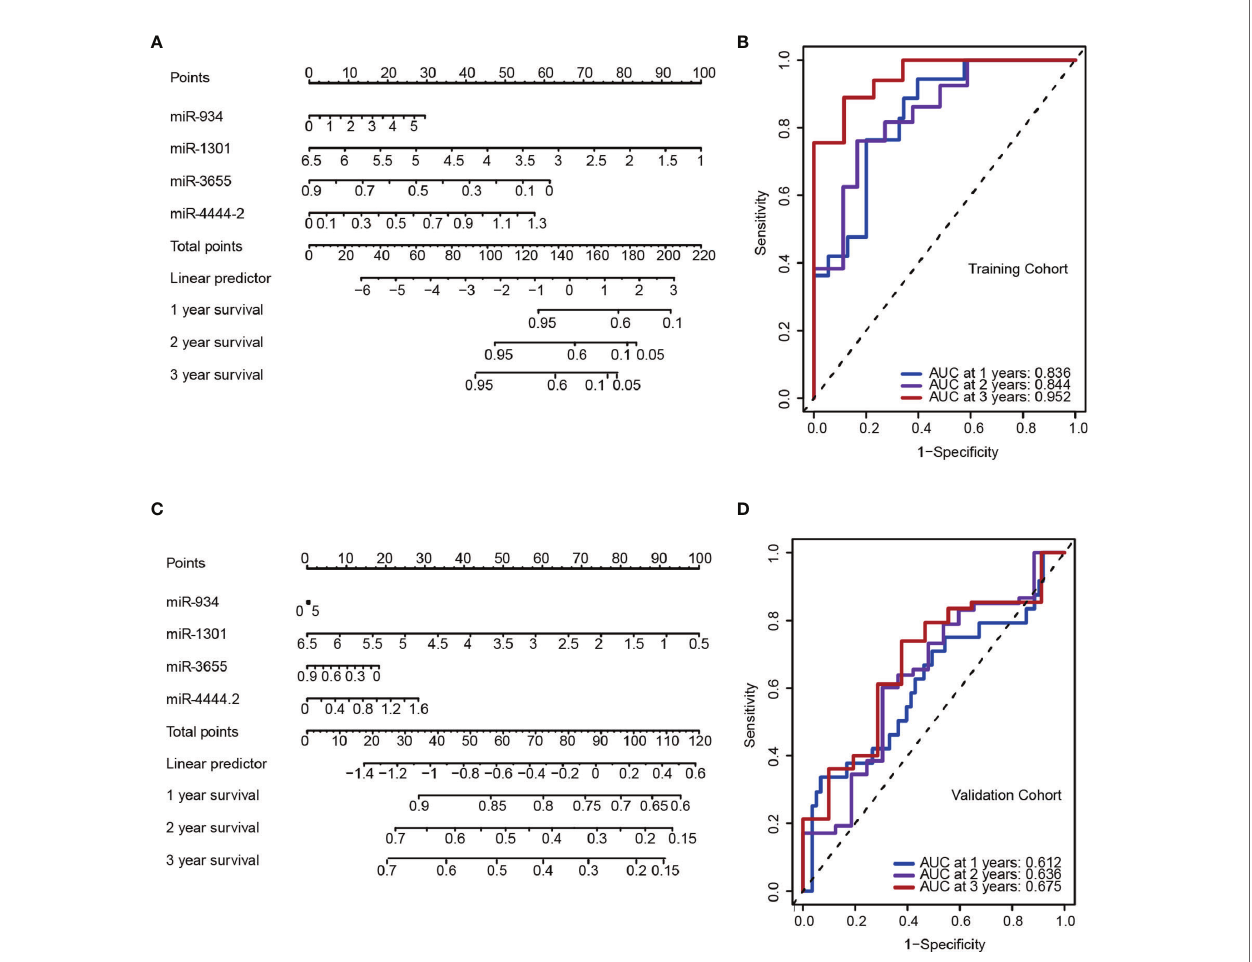
FIGURE 3 | A 4-miRNA panel was established to predict the overall survival (OS) of pancreatic adenocarcinomas (PAAD) patients. (A, C) Nomogram model of the 4-miRNA panel for predicting the probability of 1-, 2-, and 3-year OS in the training (A) and the validation cohort (C) . (B, D) Time-dependent ROC analysis at 1, 2 and 3 years in the training (B) and the validation cohort (D)